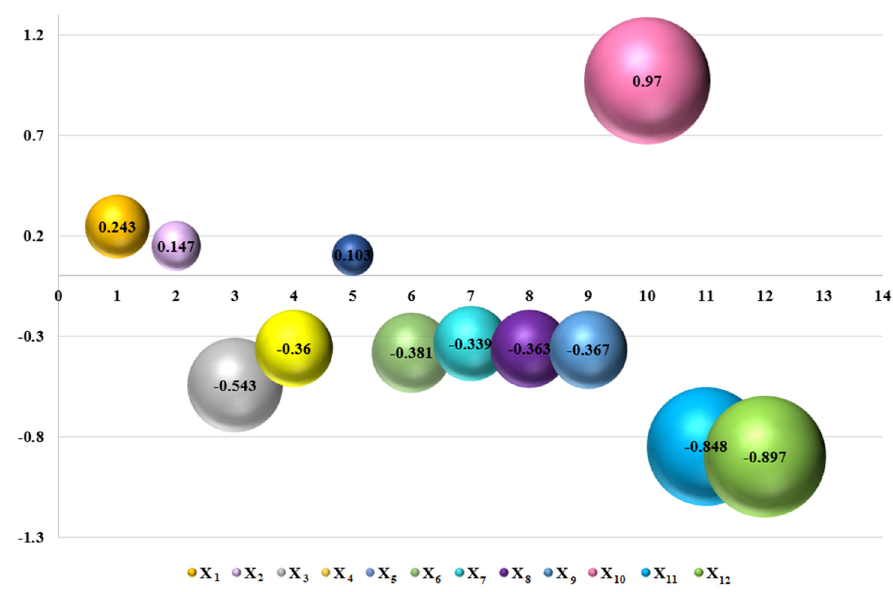
Figure 4. Pearson correlation coefficient results (X 1 to X 12 passed the significance test, ( p < 0.001); the meanings of different indicators are listed in Table 2).